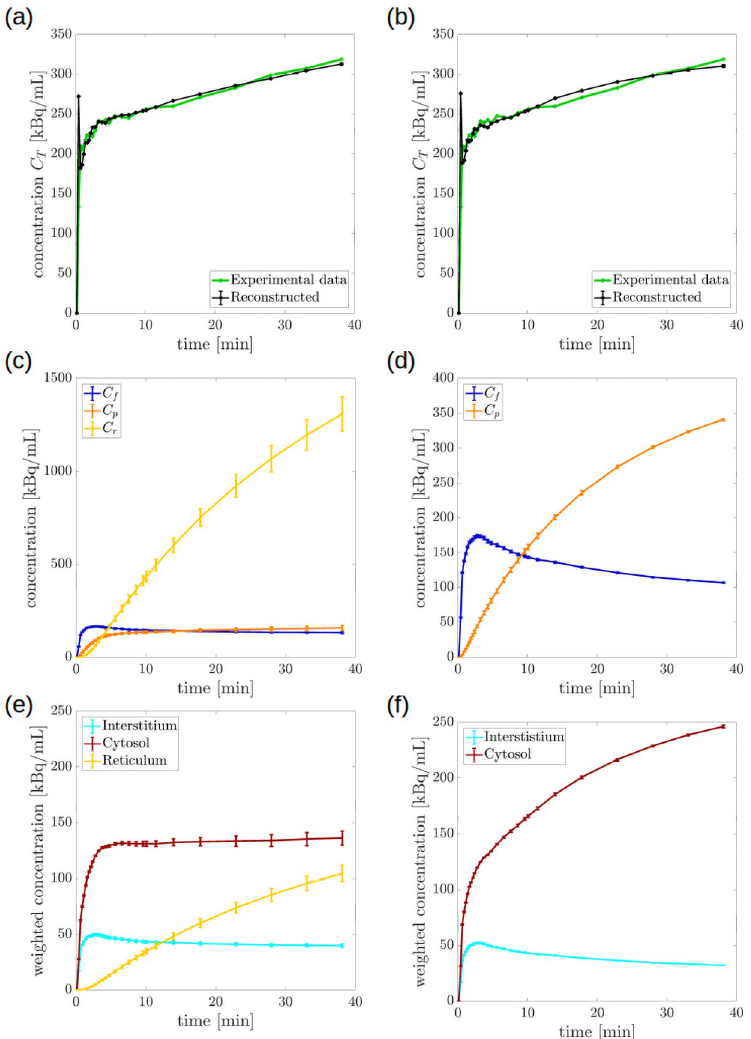
Fig 4. Model-predicted time curves of the ROI concentration and of the compartment activity for mouse m1. (a, b) Experimental and reconstructed curve of the concentration C in BCM and SCM, respectively; (c) C f , C p and C r of T BCM; (d) C f , and C p of SCM; (e) contribution to the total concentration due to tracer in the interstitial fluid, V int � � the cytosol, V cyt , and in the ER, V er þ C of BCM; (f) contribution to the total concentration due to tracer in the C C f p r V tot V tot � � interstitial fluid, V int , of SCM. All the panels show average and standard error of the , and in the cytosol, V cyt þ C C C f f p V tot V tot mean of the curves predicted across 50 repetitions of the reg-GN